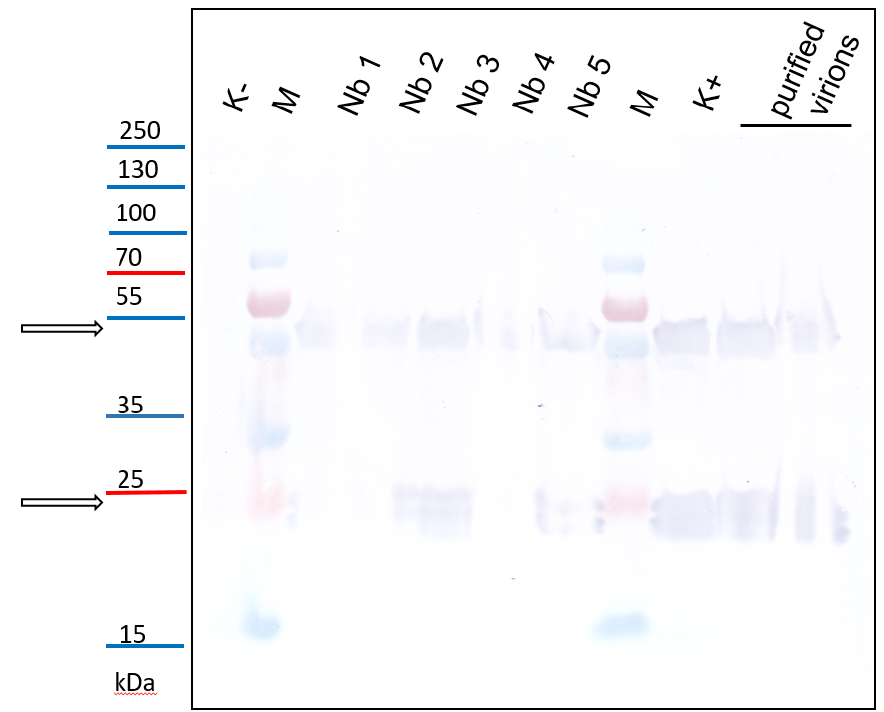
Figure 7. Detection of PSV coat protein in N. benthamiana plants inoculated with virus-exposed larvae of B. impatiens by western blotting. K − —healthy plant, untreated N. benthamiana ; samples Nb1-5: N. benthamiana plants inoculated with B. impatiens larvae; M—protein marker PageRuler™ Prestained Protein Ladder Plus (Thermo Scientific, Lenexa, KS, USA), K+—positive control, PSV-inoculated plant; purified virions: as positive controls protein extracts from native virus preparations were also used. The PSV coat protein and its dimers are indicated by black arrows.